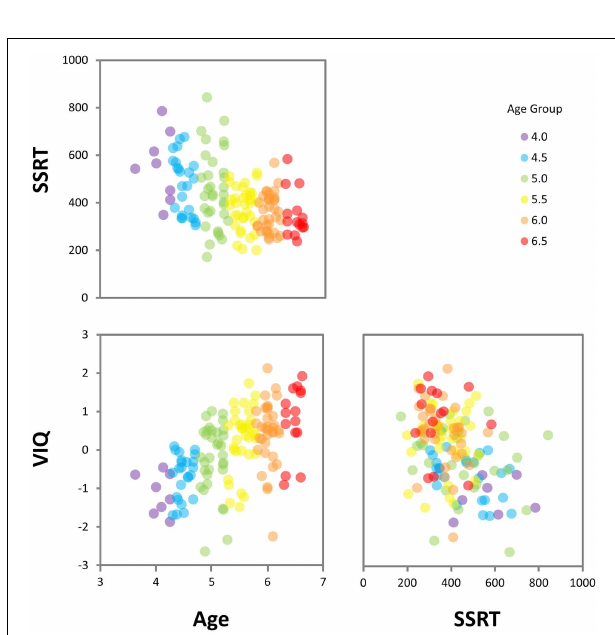
not in PIQ or RCPM. (SSRT, stop-signal reaction time; VIQ, Verbal IQ score; PIQ, Performance IQ score; RCPM, Raven’s Colored Progressive Matrices).